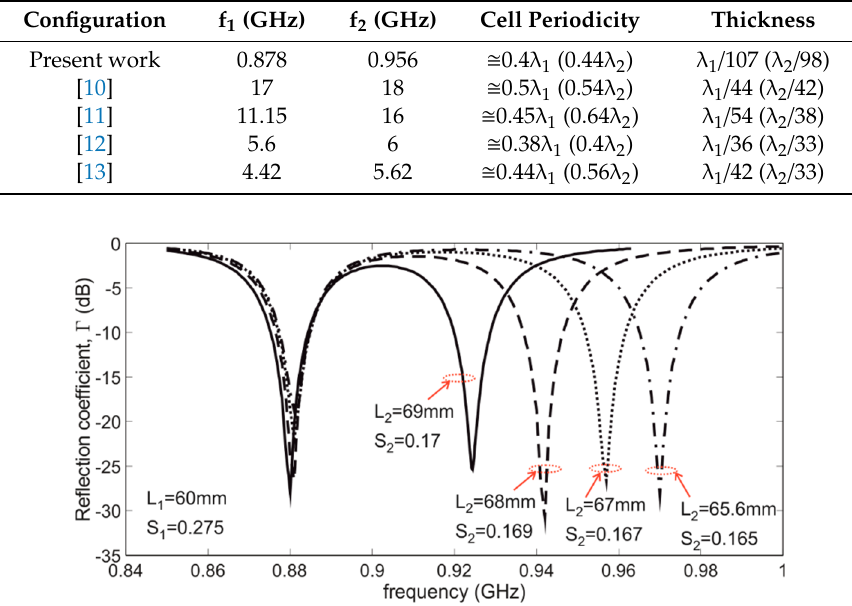
Figure 5. Reflection coefficient vs. frequency of a synthesized dual-band MA for different (L 2 , S 2 )-values ( ε r = 4.2, tan δ = 0.015 and h = 3.2 mm–D ≅ 0.4 λ @ f 1 ).